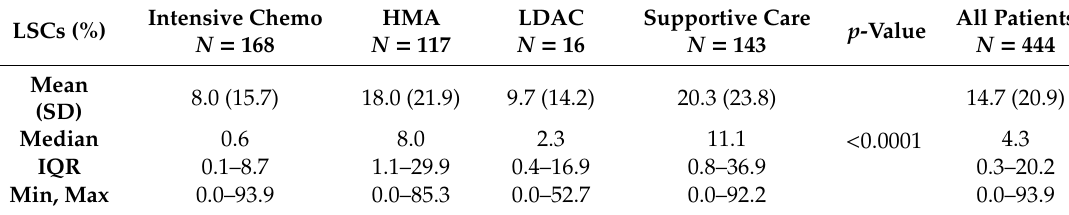
Table 3. Distribution of the % of leukemic stem cells according to treatment